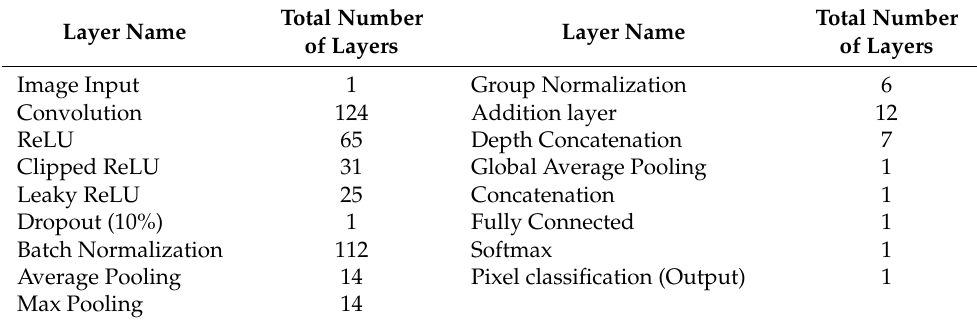
Table 1. Statistics of the HortNet417v1 architecture.